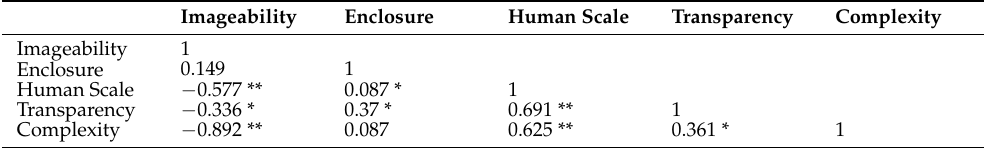
Table 5. Correlation among the five qualities.